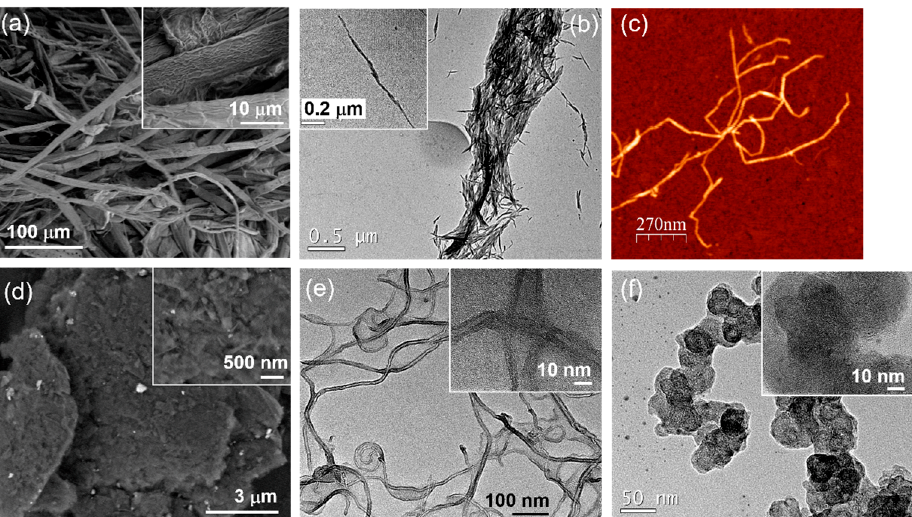
Figure 1. Morphology of starting nanomaterials. SEM image of cellulose pulp and high magnification of the fiber surface (inset) ( a ), TEM image of microcrystalline cellulose ( b ), AFM image of cellulose nanofibers ( c ), SEM image of graphene nanoplatelets ( d ), TEM images of multiwalled carbon nanotubes ( e ) and carbon black ( f ). High-magnification images are inset. The nanocarbon materials were sonicated and stabilized with 0.4 mg/mL CTAB prior to observation.